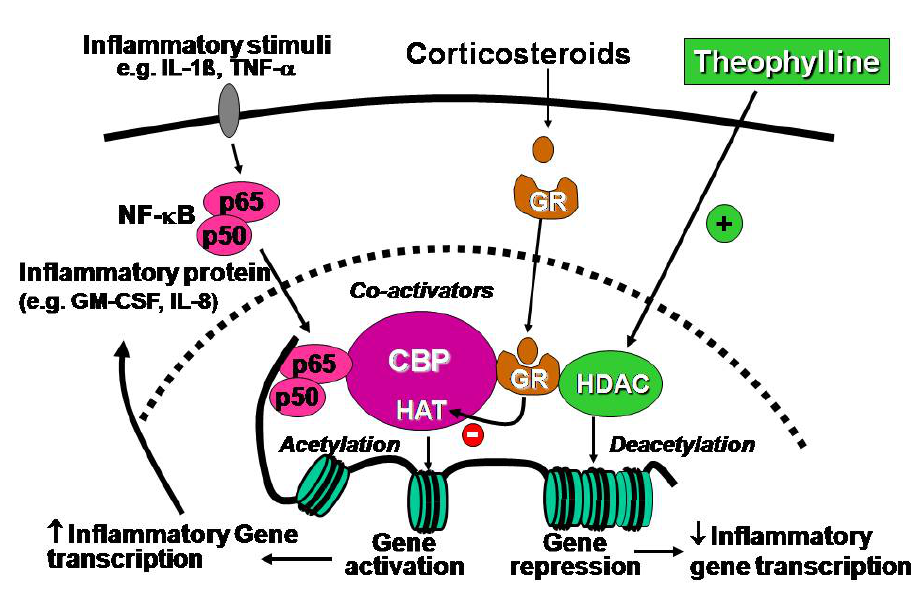
Figure 2. Theophylline directly activates histone deacetylases (HDACs) which deacetylate core histones that have been acetylated by the histone acetyltransferase (HAT) activity of co-activators, such as CREB-binding protein (CBP). This results in suppression of inflammatory genes and proteins, such as granulocyte-macrophage colony stimulating factor (GM-CSF) and interleukin-8 (IL-8) that have been switched on by proinflammatory transcription factors, such as nuclear factor-  B (NF-  B). Corticosteroids also activate HDACs, but through a different mechanism resulting in the recruitment of HDACs to the activated transcriptional complex via activation of the glucocorticoid receptors (GR) which function as a molecular bridge. This predicts that theophylline and corticosteroids may have a synergistic effect in repressing inflammatory gene